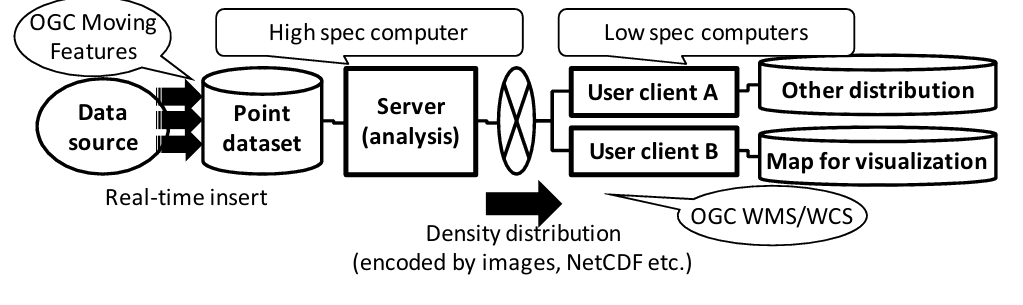
Figure 2. A system using point